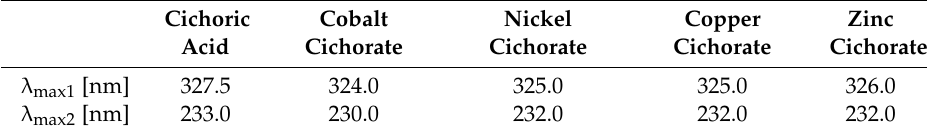
Figure 6. The absorption spectra of cichoric acid and complexes with copper, zinc, cobalt, nickel (210–400 nm, aqua solution 5 × 10 − 5 mol / dm 3 ). Table 4. The absorbance maximum in the UV spectra of cichoric acid and its metal